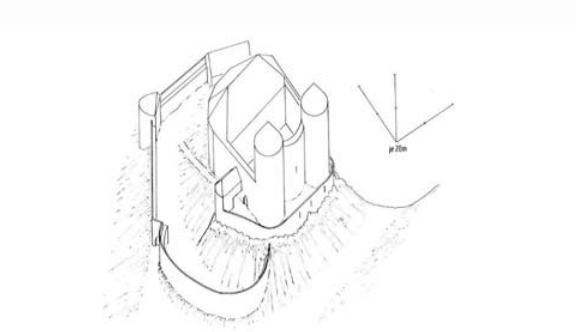
Figure 7a : Isometric reconstruction carried out by (Biller and Metz, 1995), which uses all the hypotheses collected.